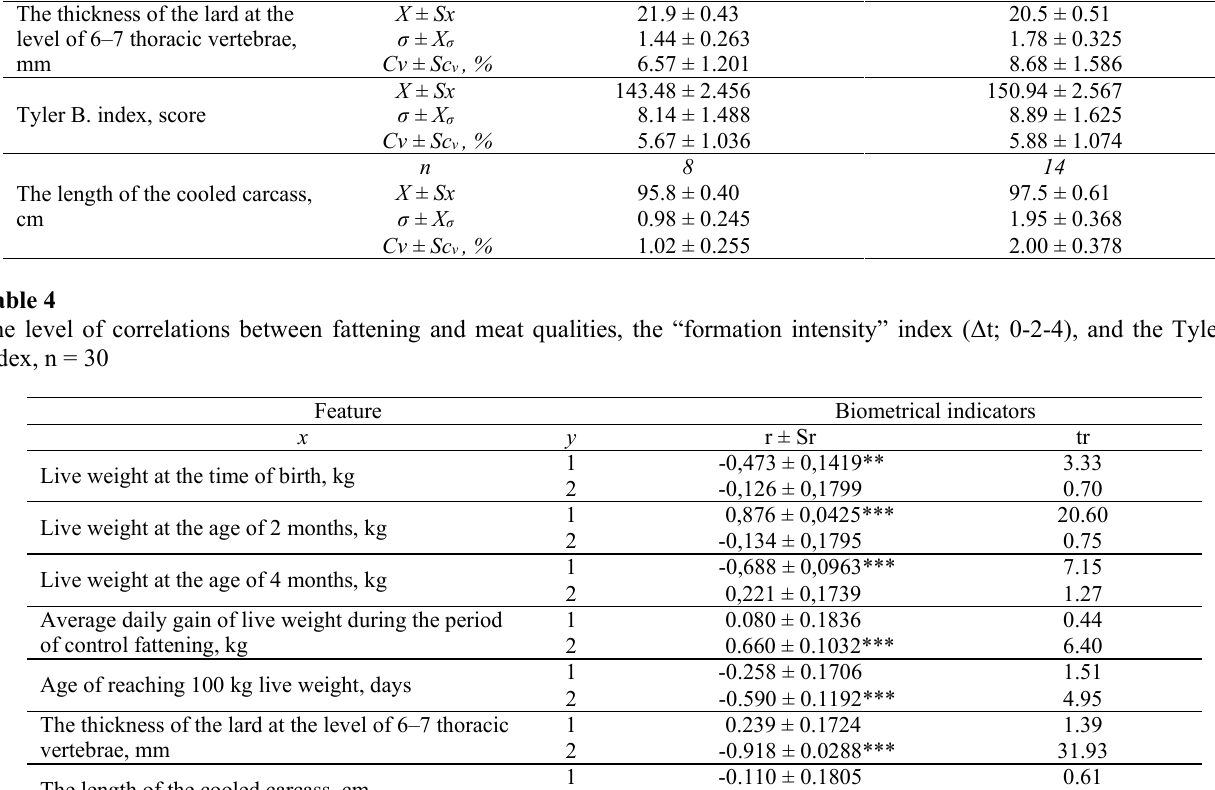
The fattening and meat qualities of young pigs of different interbreed differentiation according to the coefficient of growth decline ( ∆K ), n = 15 Indicator (sign), units of measurement Average daily gain of live weight